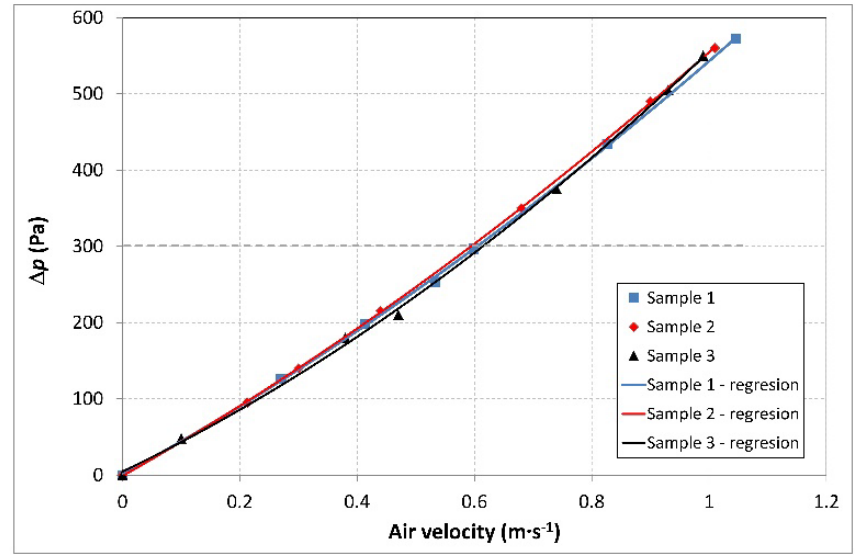
Figure 8. A comparison of pressure drops in three samples of P-Cu-AW-315 filters. A pressure drop deviation at a velocity of 0.6 m · s − 1 , which corresponds to a pressure drop of 300 Pa, amounted to 7.5%.